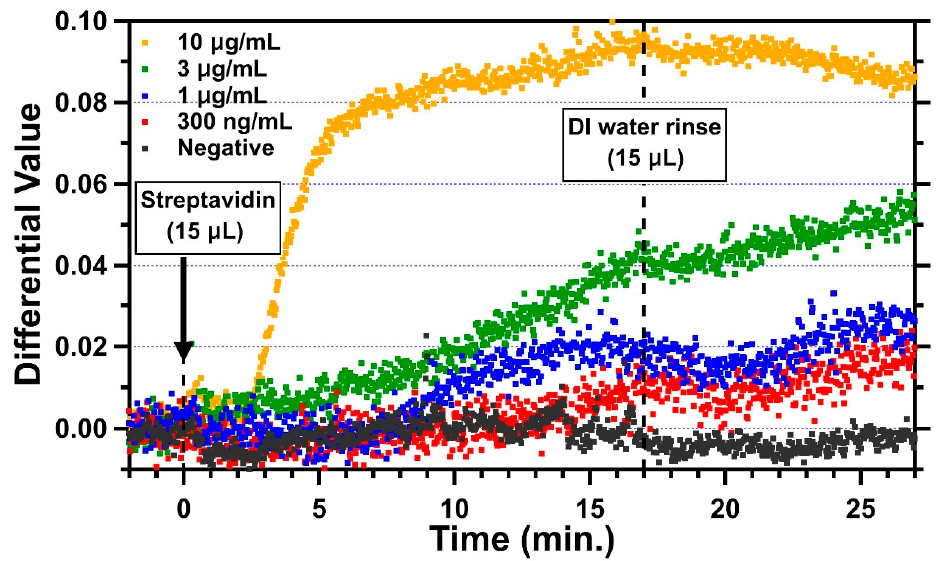
Figure 5. Real-time measurements for 30 min showing the changing differential values after the introduction of 15 µL of streptavidin for four different concentrations and the negative control (10 µg/mL: yellow; 3 µg/mL: green; 1 µg/mL: blue; 300 ng/mL: red; and negative control: